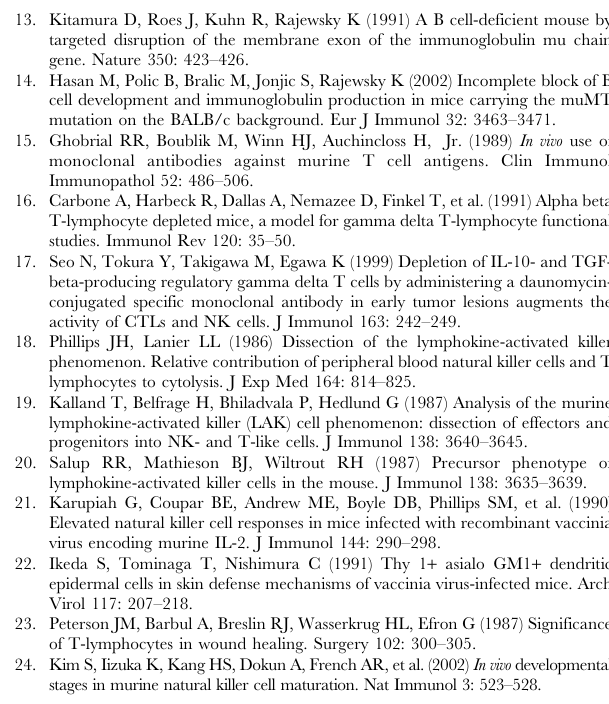
Figure S3 NK cells transferred into RAG1 ko hosts persist and do not contain contaminating T